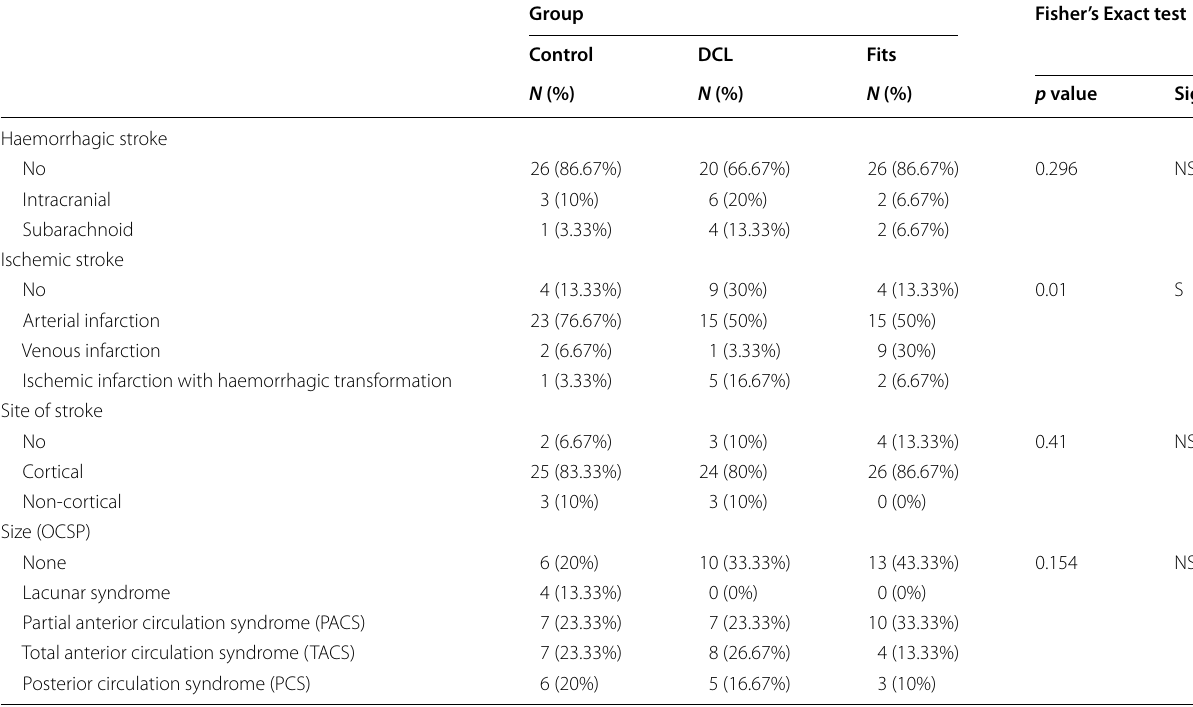
Table 3 Type, site and size of stroke in the three groups